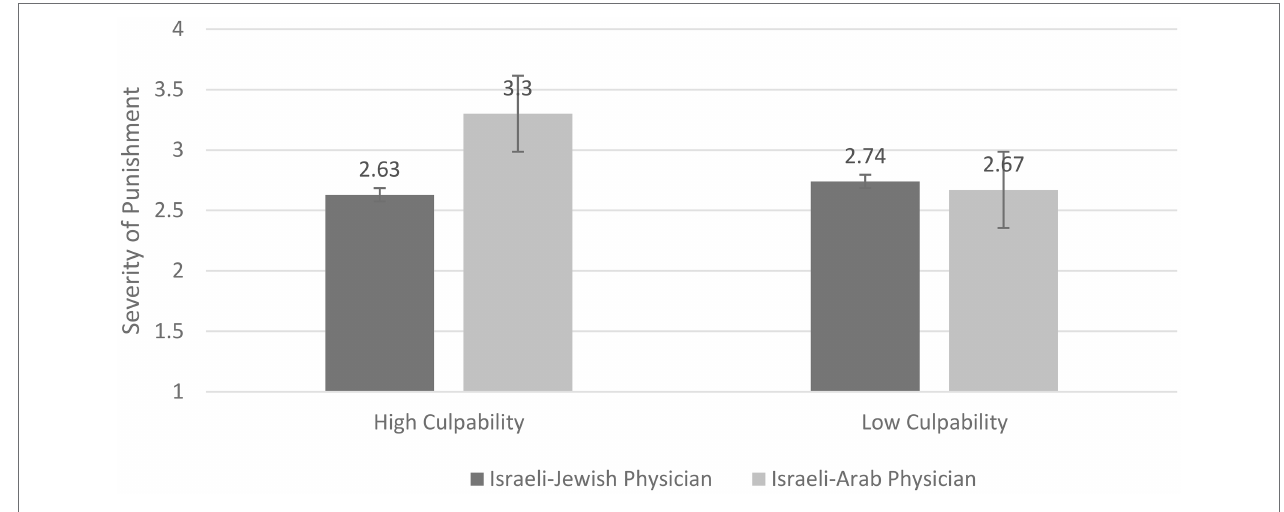
FIGURE 3 | Severity of Punishment as a function of Physician’s Ethnicity and